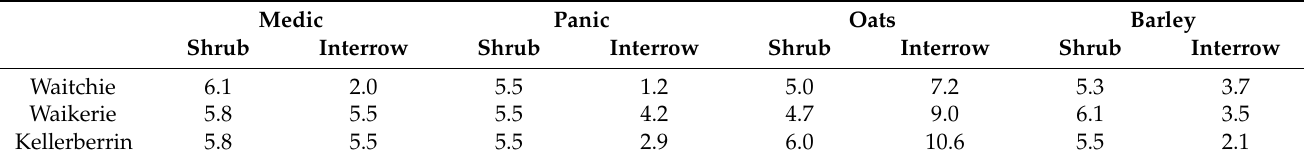
Table 2. Feed on offer (GJ ME/ha) on 1 February (day 31) available of shrub and different interrow species after lowest 20% rainfall year at Waitchie (2006, 2015, 2018, 2002), Waikerie (2006, 2015,